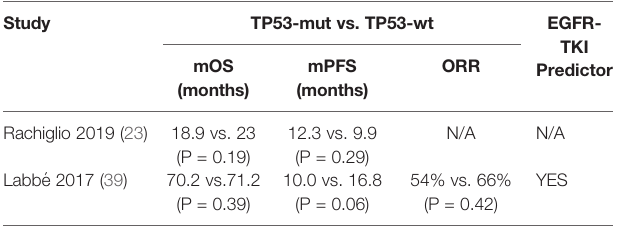
TABLE 2 | TP53 co-mutation is not associated with prognosis in EGFR-mutated NSCLC patients. Study TP53-mut vs. TP53-wt EGFR-